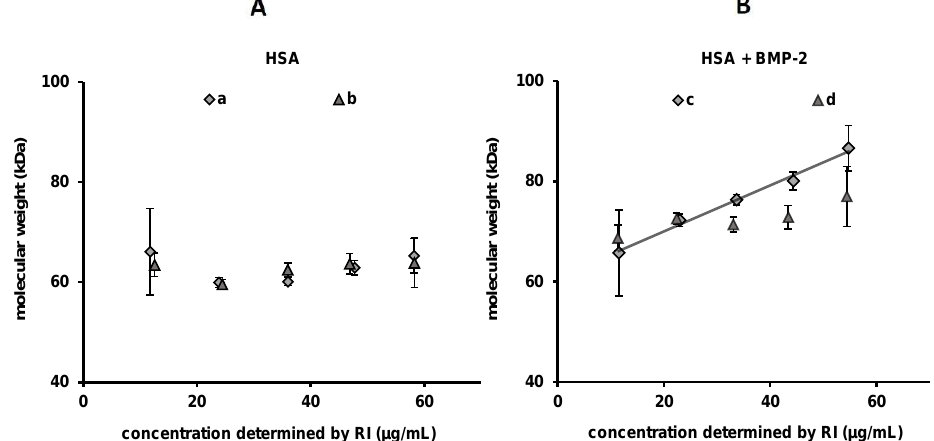
Figure 10. Molar masses of two sets of measurements with a one-day interval in PBS buffer pH 7.4. ( A ) Diluted from a 1.15 mg / mL HSA solution. ( B ) Diluted from a mixture of 0.2 mg / mL BMP-2 and 1.15 mg / mL HSA. Each symbol represents a single measurement. Error bars indicate standard deviation of the determined molecular weights given by Debye